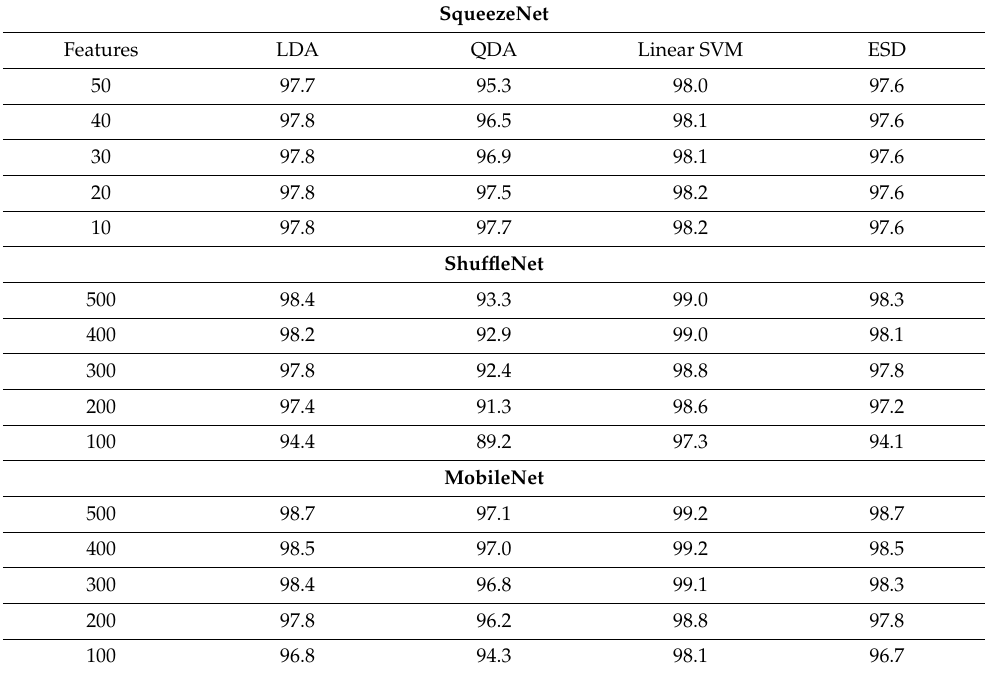
Table 3. Classification accuracies (%) for different feature sets after the process conducted for the deep features of the three